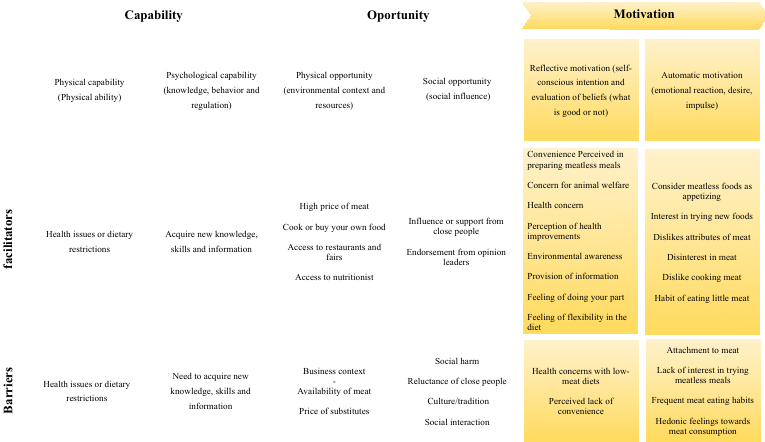
Figure 2. Facilitators and barriers for reducing meat consumption in Brazil. Note: Classification based on the study by Graça et al. [25].